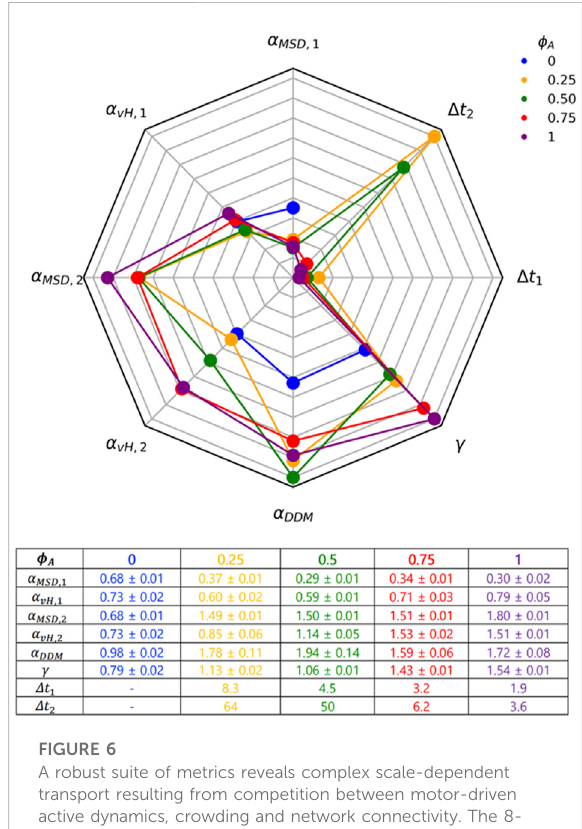
FIGURE 6 A robust suite of metrics reveals complex scale-dependent transport resulting from competition between motor-driven active dynamics, crowding and network connectivity. The 8- variable spider plot shows how the key metrics we use to characterize transport depend on ϕ A (color-code shown in legend). A greater distance from the center signi fi es a larger magnitude. α values determined from DDM ( α DDM ), SPT , α MSD , , α vH , , α vH , MSDs ( α MSD , 1 1 2 2 and SPT van Hove distributions ( α vH , 1 , α vH , 2 ) are scaled identically for direct comparison, as are the two timescales determined from MSD s ( Δ t 1 , Δ t 2 ). The stretching exponent γ is scaled independently. The table provides the values with error for each metric